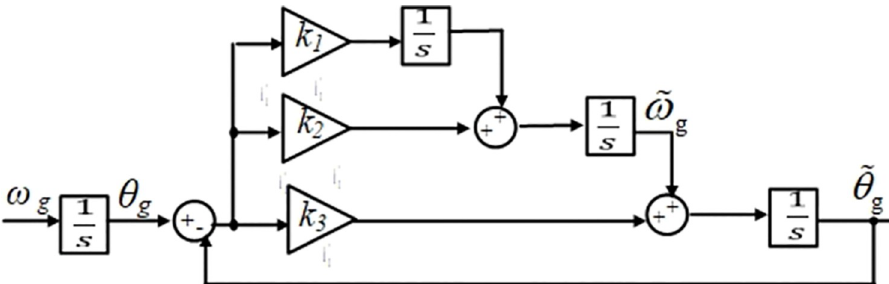
Fig 5. Small signal model of the linear PLL based on Kalman